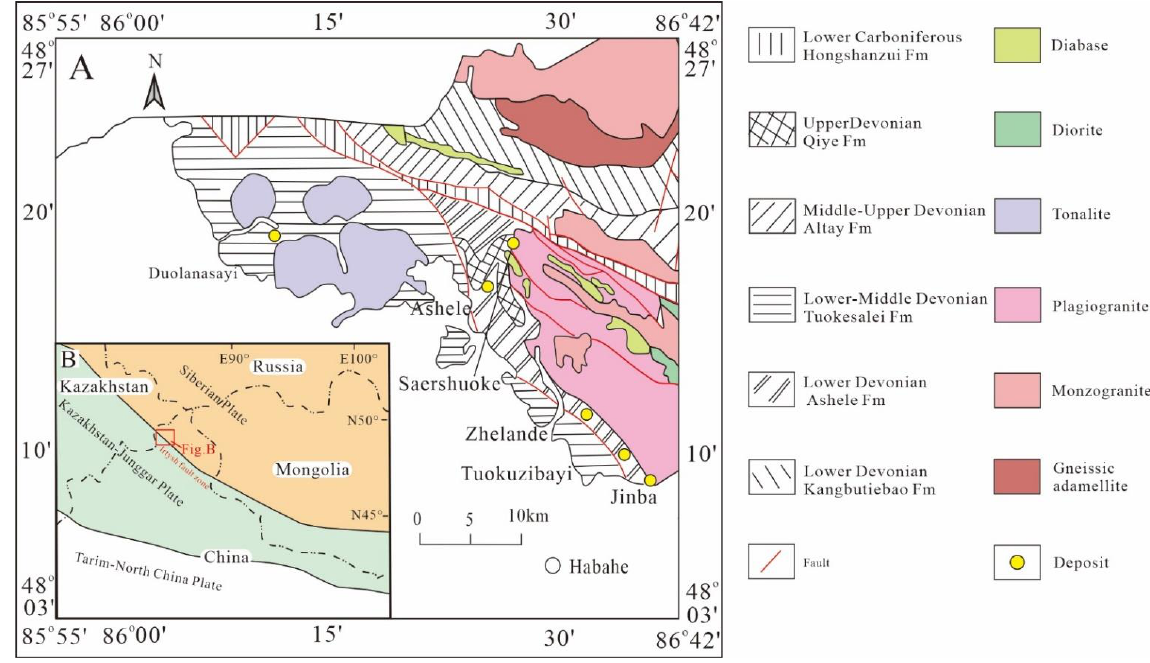
Figure 1. ( A ) Tectonic map of western China. ( B ) Regional geological map of the southwestern Chinese AOB (modified after Zhan et al. [20]).